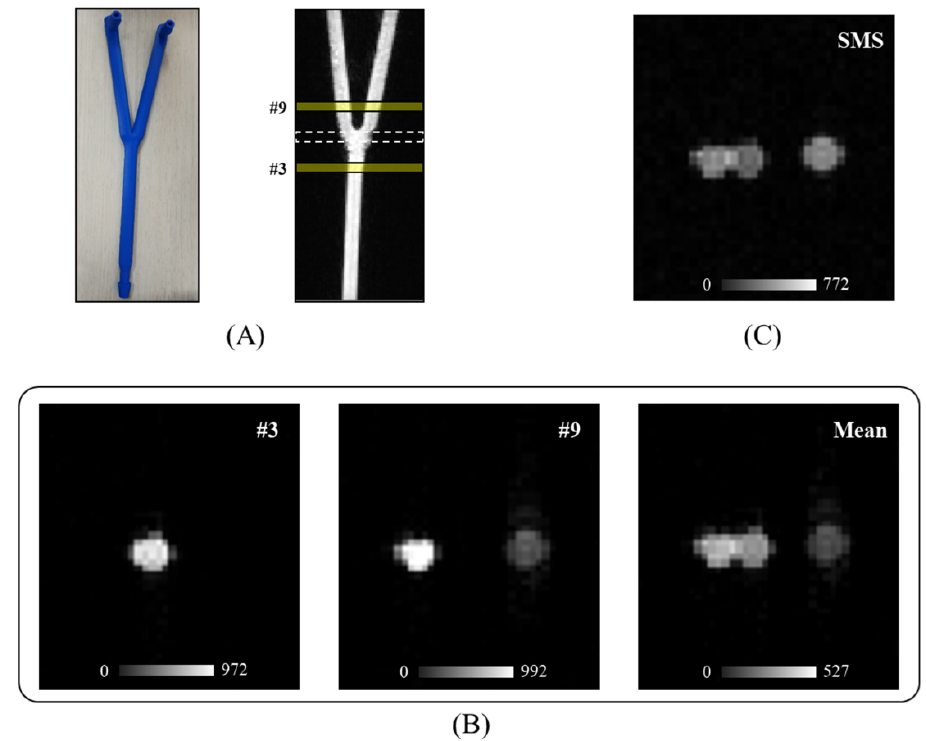
Figure 2. Phantom images comparing the SMS-K image with the mean GRE image of two selected slices. ( A ) The 3D modeling image and the phantom image acquired with 3D TOF MRA. ( B ) GRE images and the mean image of the 3rd and 9th slices. ( C ) SMS-K image acquired simultaneously on the 3rd and 9th slices. Gray scale bars indicate the signal intensity. Abbreviations: 3D TOF MRA, 3-dimensional time-of-flight magnetic resonance angiography; GRE, gradient echo; SMS-K, simultaneous multi-slice keyhole technique; 3D, 3 dimensional. Table 1. MR parameters for cerebral-artery PWV.